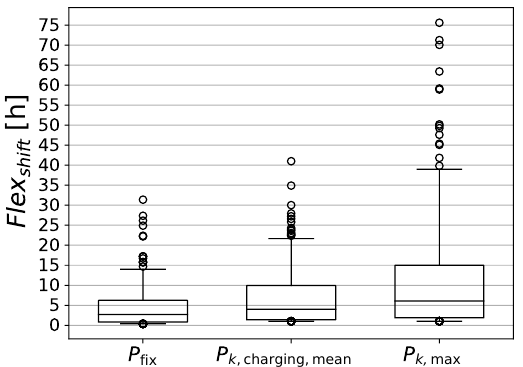
Figure 11. Flex shift potential for the logistics site.